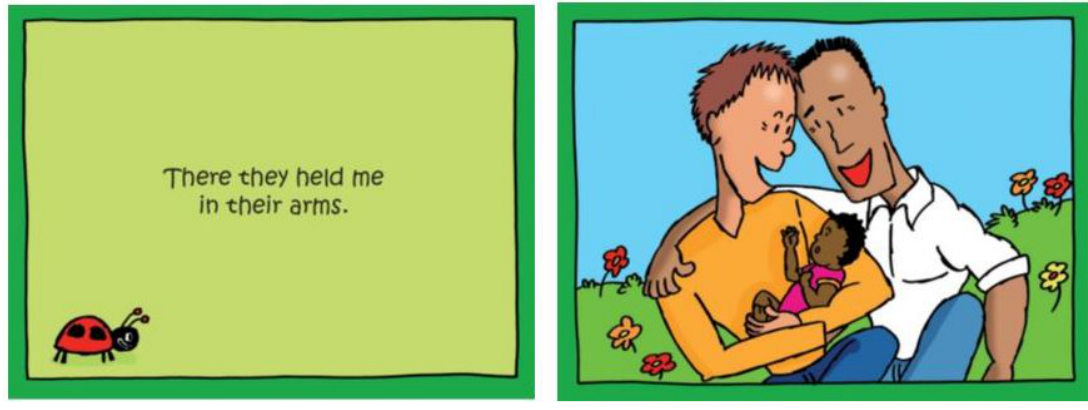
Figure 16. Transatlantic adoption across the color line.